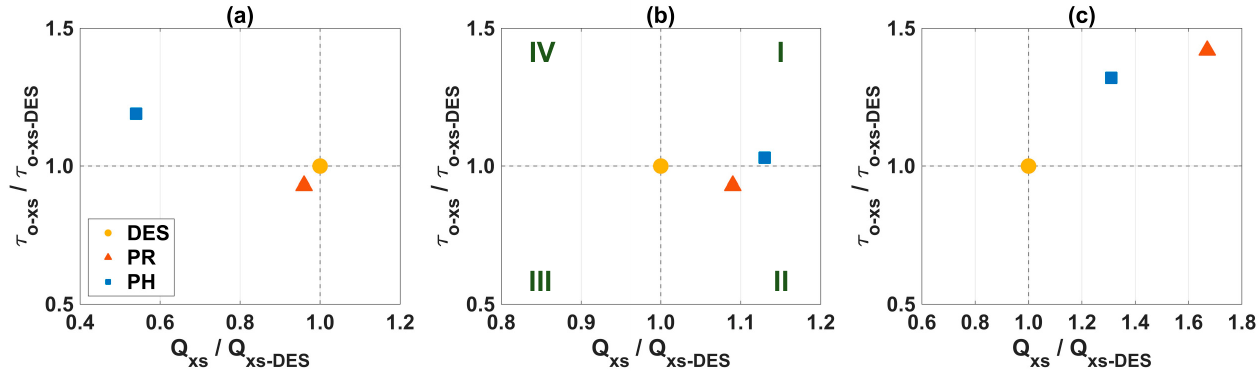
Figure 7. Values of Q xs and τ o-xs for the Post-Restoration (PR) and Post-Hurricane (PH) geometries normalized by those corresponding to the Design (DES) geometry ( Q xs-DES and τ o-xs-DES ) for ( a ) XS #4, ( b ) XS #7, and ( c ) XS #8. Quadrant Descriptions: I—widening with bed erosion and bank retreat; II—widening with bed deposition; III—narrowing with bed deposition; and IV—incision with bed erosion and bank retreat.